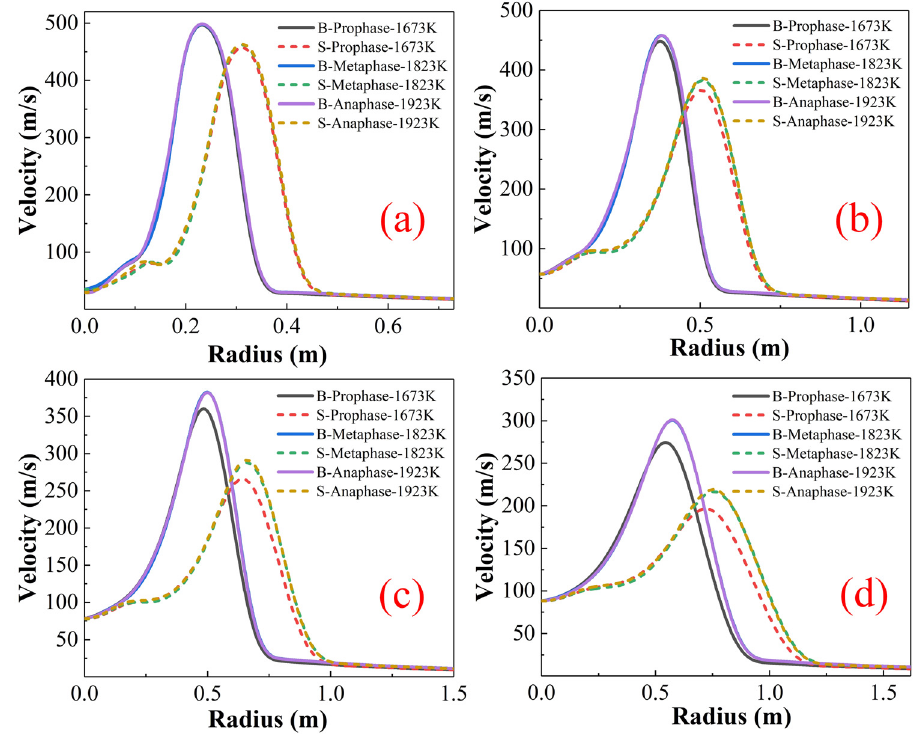
Figure 14: Distribution of the jet radial velocity for di ff erent smelting periods: ( a ) 600 mm, ( b ) 1,300 mm, ( c ) 2,000 mm, and ( d ) 2,700